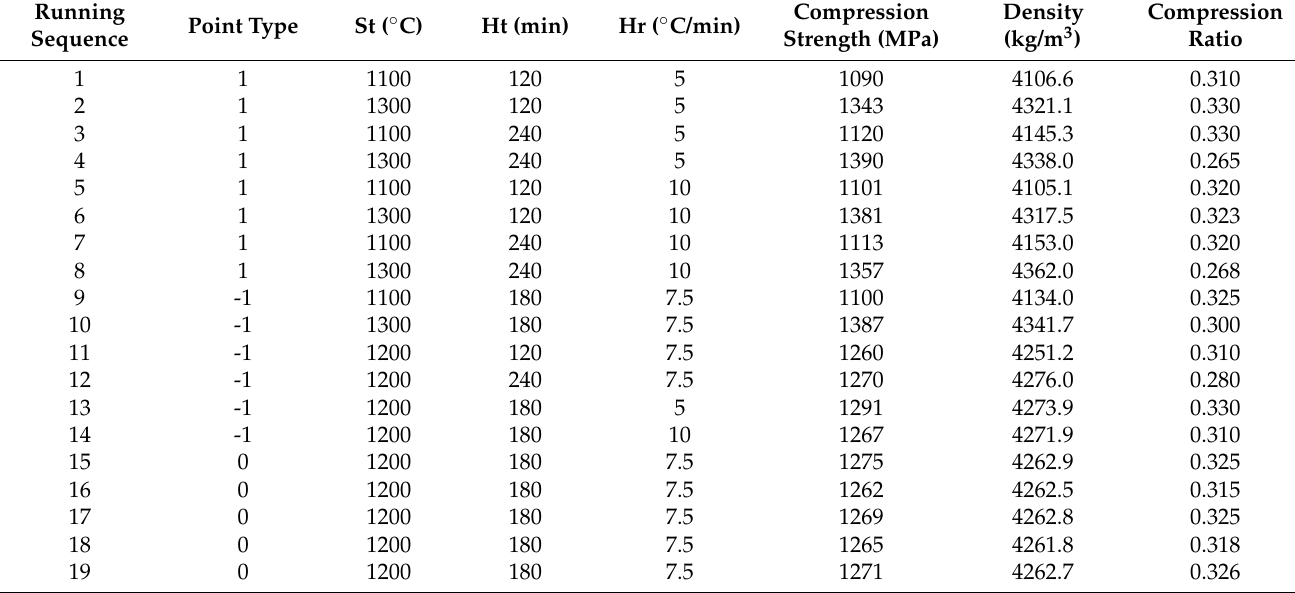
Table 4. The input factors and output results of sintering